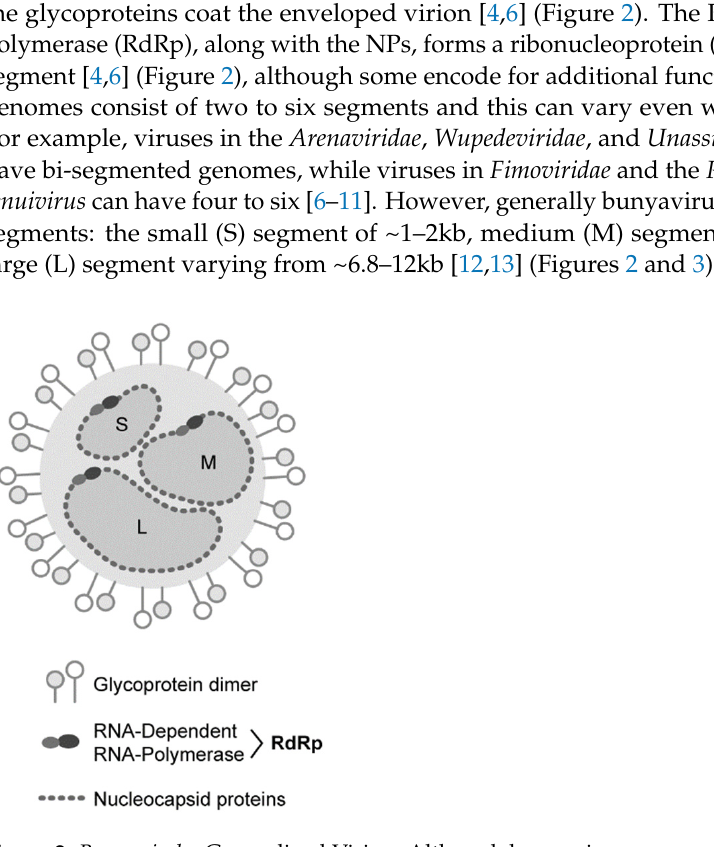
Figure 2. Bunyavirales Generalized Virion. Although bunyaviruses can vary in number of genomic segments and glycoprotein dimer structure, all viruses share a similar structure. Nucleocapsid proteins coat the single-stranded anti-sense RNA genomes and along with the RNA-dependent RNA-polymerase form ribonucleoproteins on each segment. The genomic segments are packaged in an enveloped virion studded with the viral glycoproteins. The genomic small, medium, and large segments are labeled S, M, and L, respectively.